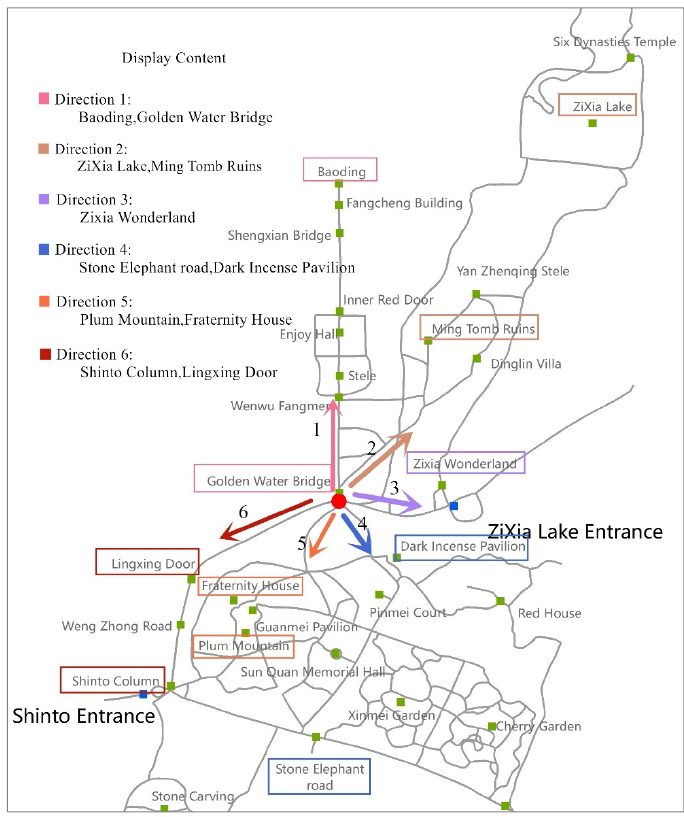
Figure 8. The representative example of display content in the first type, the content displayed in each direction is shown in a different color of arrow and box.